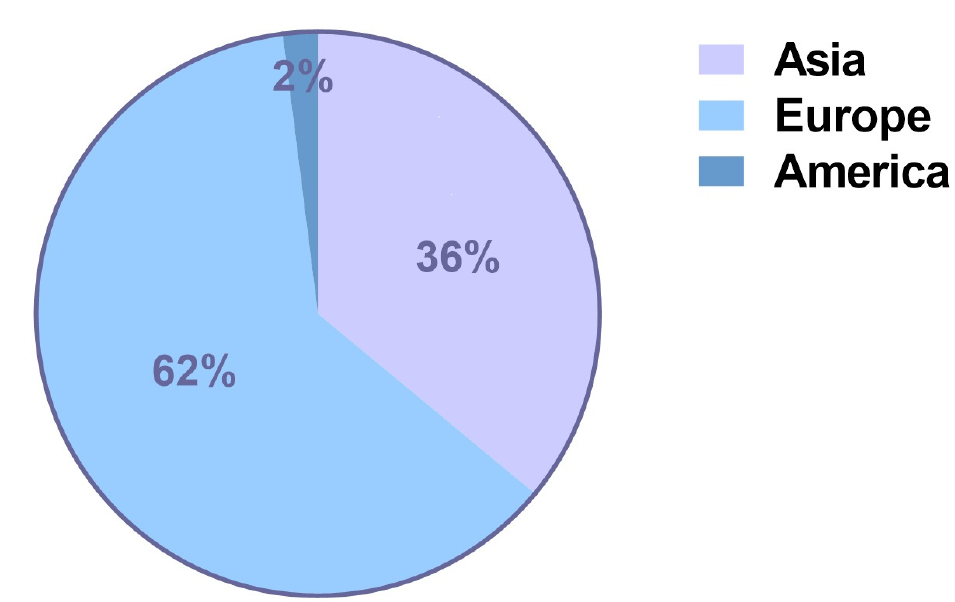
Figure 4. Continent distribution of the patient enrolled in the selected Motiva studies.